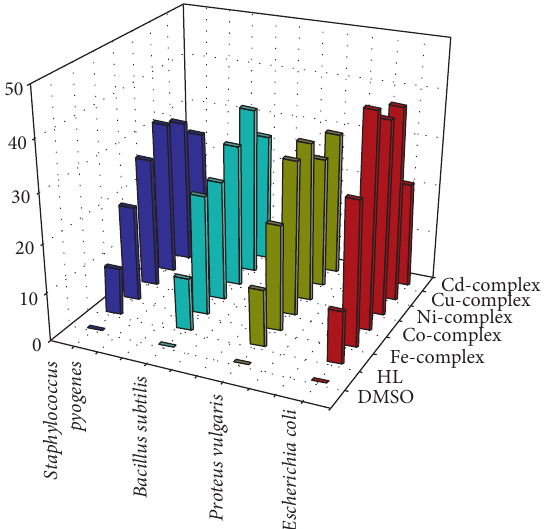
Figure 5: Biological activity of triazole ligand and its metal